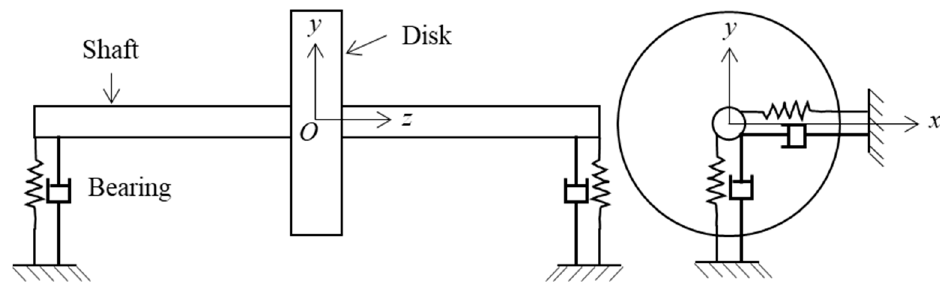
Figure 3. Simple rotor-disk system for the generation of a large amount of source data. The shaft is supported by two bearings at the ends; the bearings are linearized, ide- ally with stiffness and damping. The support and/or foundation are assumed to be rigid.